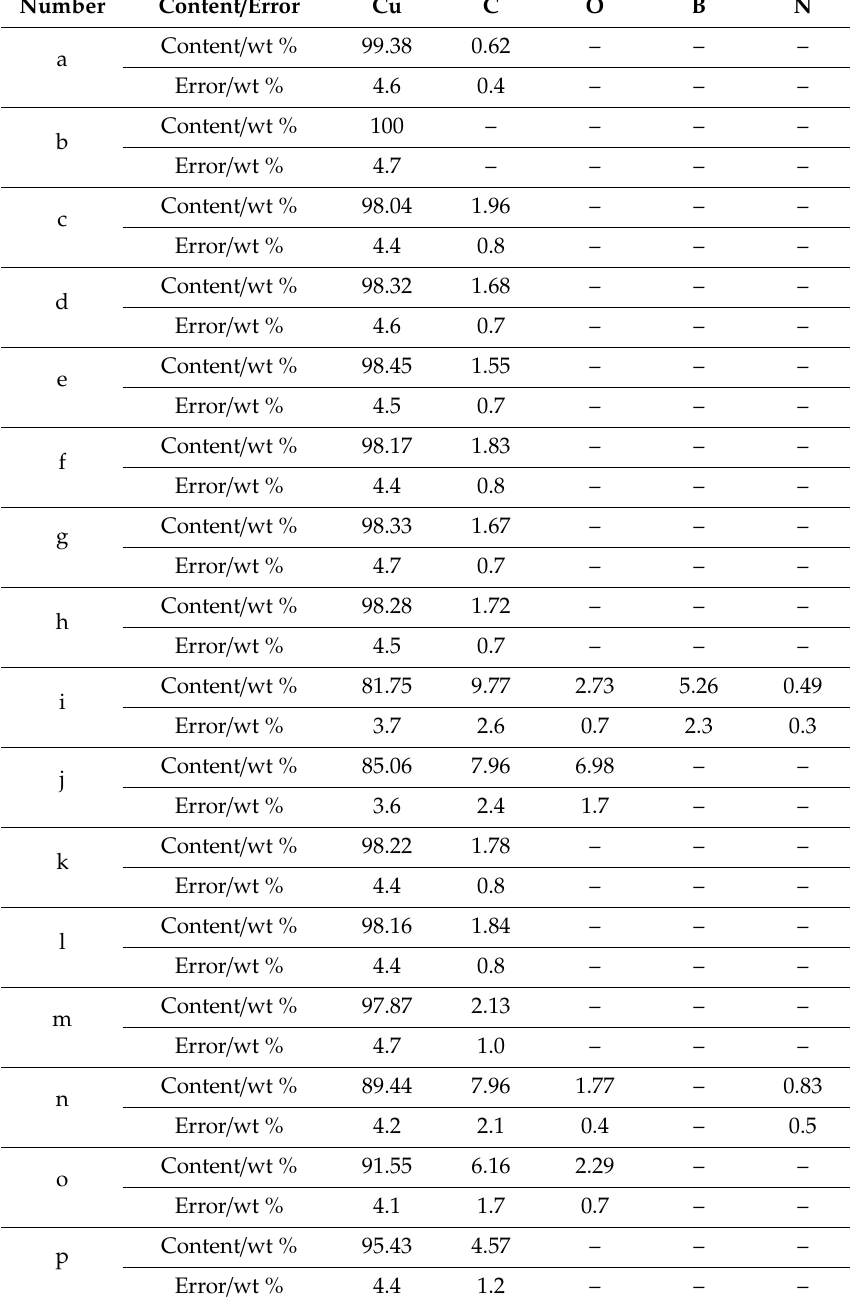
Table 2. Quantitative elemental analysis of the original rolled copper foil surface (a),(b) and corrosion products of the rolled copper foil surface corroded in condition B (c),(d); condition C (e), (f); condition D (g), (h); condition E (i), (j); condition F (k), (l), (m) and condition A (n), (o),